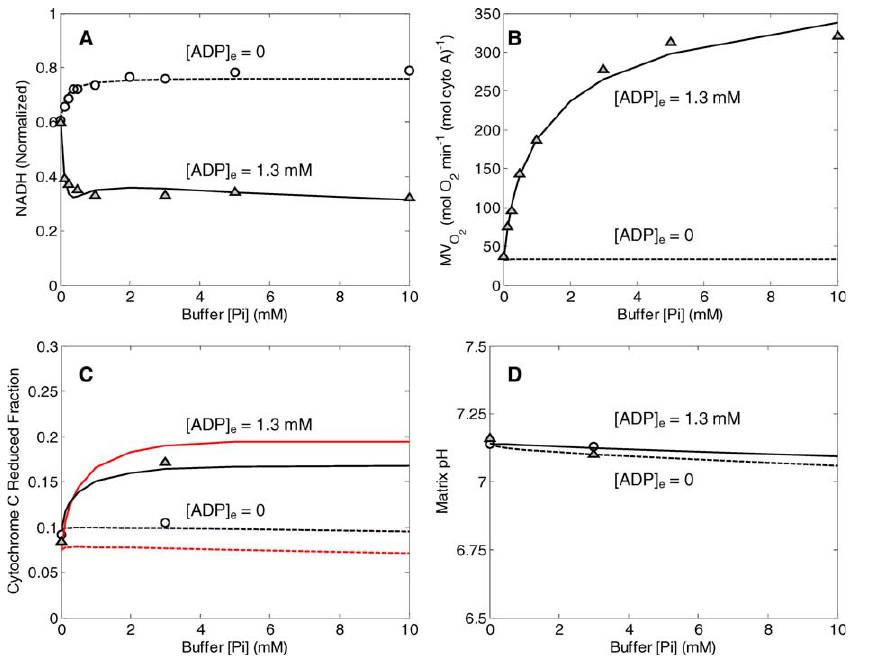
Figure 2. Comparison of Model Simulations to Experimental Data on NADH, MV O2 , Cytochrome C Redox, and Matrix pH for Model without Phosphate Control (A) Results for normalized matrix NADH as a function of buffer inorganic phosphate concentration are shown for the two experimental cases of resting mitochondria ([ADP] e ¼ 0, state 4) and active state mitochondria ([ADP] e ¼ 1.3 mM, state 3). (B) Results for MV O2 (rate of oxygen consumption) are shown for the same experimental cases as in (A). Experimental data are not available for the resting state, in which a minimal flux through the electron transport system is maintained to compensate for cation flux across the inner membrane. (C) Results for cytochrome C reduced fraction are shown for the experimental cases as in (A). The black curves correspond to the model equations developed in the text. The red curves correspond to the best-fit model simulations obtained with equation 9 modified to not include the factor [cytC(red) 2 þ ]/cytC tot multiplying the expression for J C4 . (D) Matrix pH (model-simulated and experimentally measured) is plotted as a function of buffer phosphate for the experimental cases as in (A). All computed results in this figure correspond to steady-state simulations of model described under ‘‘ Mitochondrial Model without Phosphate Control. ’’ Model simulations for [ADP] e ¼ 1.3 mM, and [ADP] e ¼ 0 mM are plotted as solid lines and dashed lines, respectively. Experimental data (circles and triangles) are obtained from [10]. DOI: